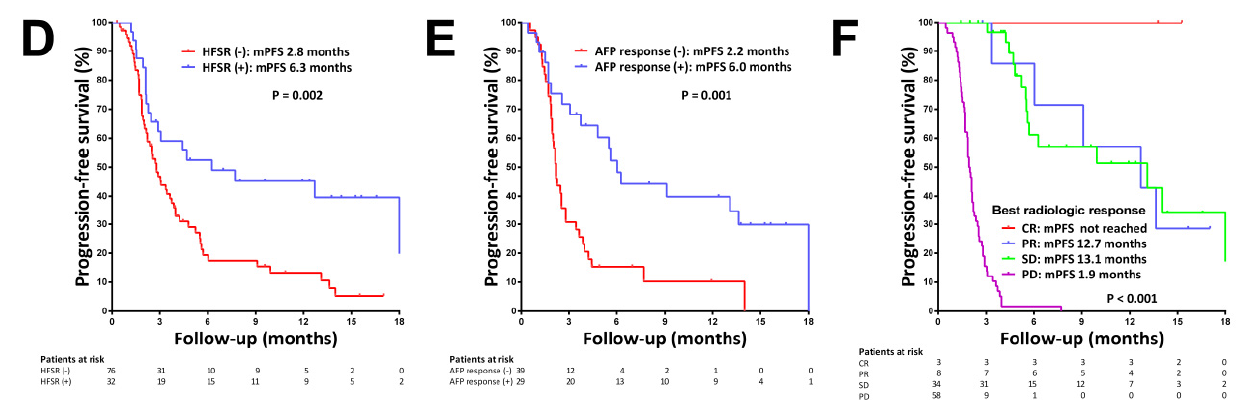
Figure 1. Kaplan–Meier curves of progression-free survival (PFS) in patients with HCC receiving regorafenib treatment. ( A ) PFS stratified by BCLC stage. ( B ) PFS stratified by lines of therapy. ( C ) PFS stratified by time-to-progression on prior sorafenib treatment. ( D ) PFS in patients with and without hand-foot skin reaction (HFSR). ( E ) PFS in patients with and without early AFP response. ( F ) PFS stratified by radiologic response by mRECIST criteria. Table 3. Independent factors associated with progression-free survival, overall survival and post- progression survival by multivariate